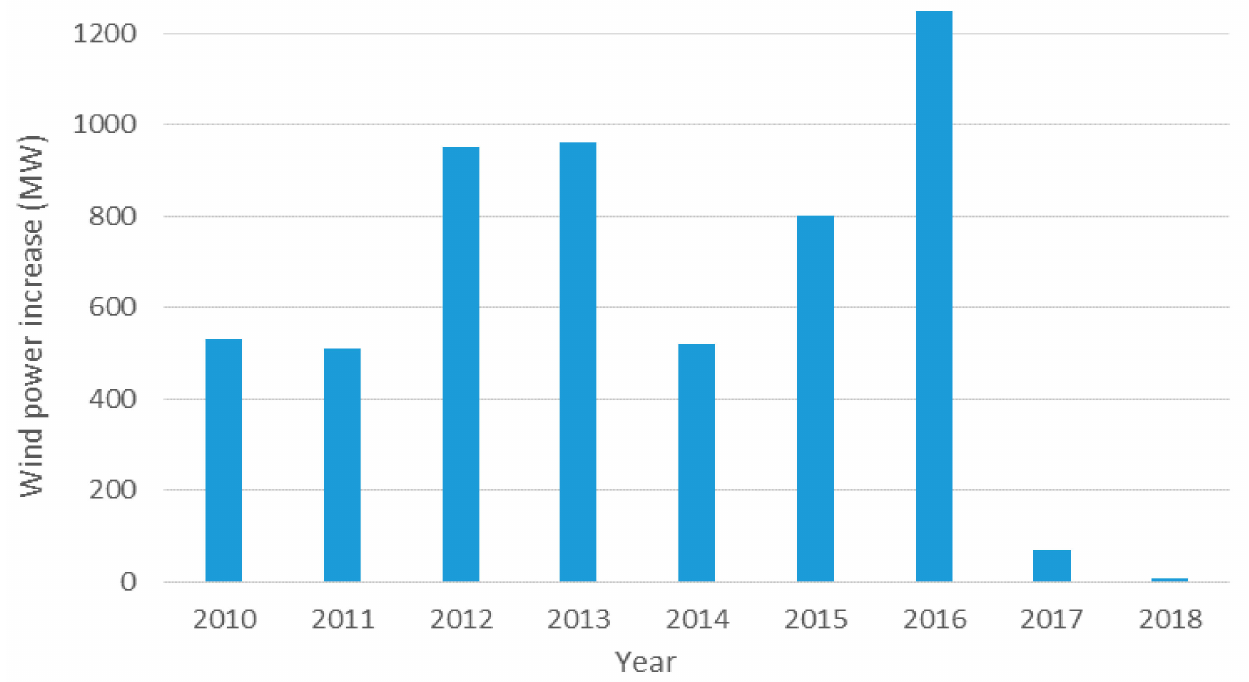
Figure 6. Aeroenergetics power increase in Poland. Own elaboration based on data from